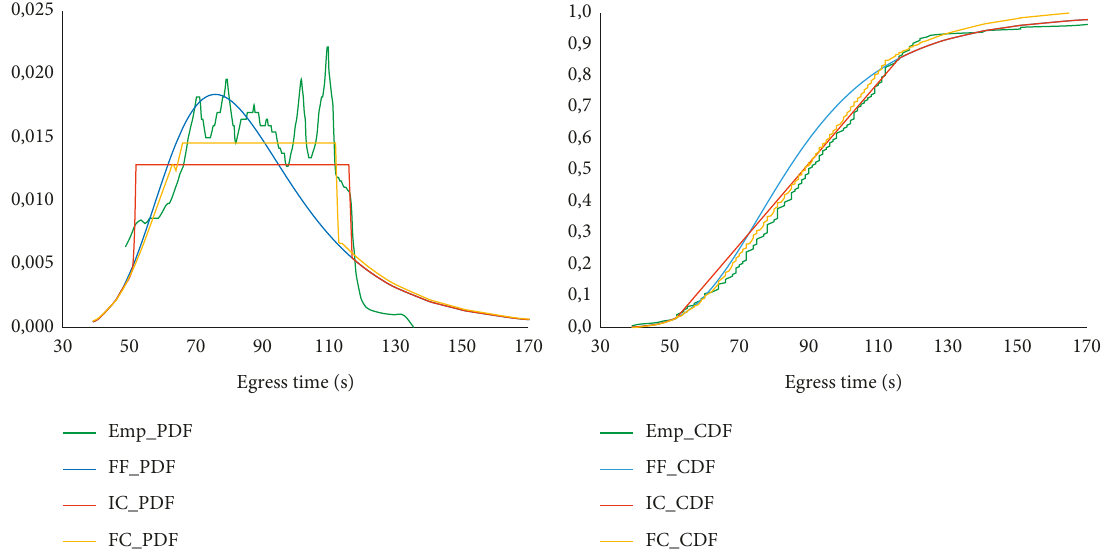
Figure 6: PDF (left side) and CDF (right side) of egress times for the train at 18: